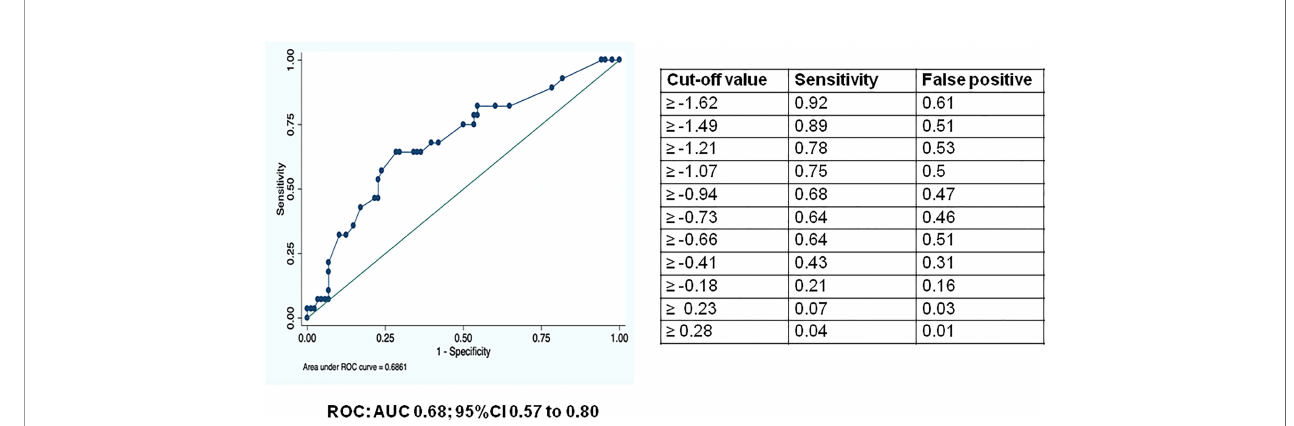
FIGURE 1 | Receiver operating characteristics (ROC) curve and area under the ROC curve (AUC) for assessing the discriminatory power of the risk score model for the prediction of CMV disease in SOT recipients, cut-off values for the ROC curve. ROC: AUC 0.68; 95%CI 0.57 to 0.80.